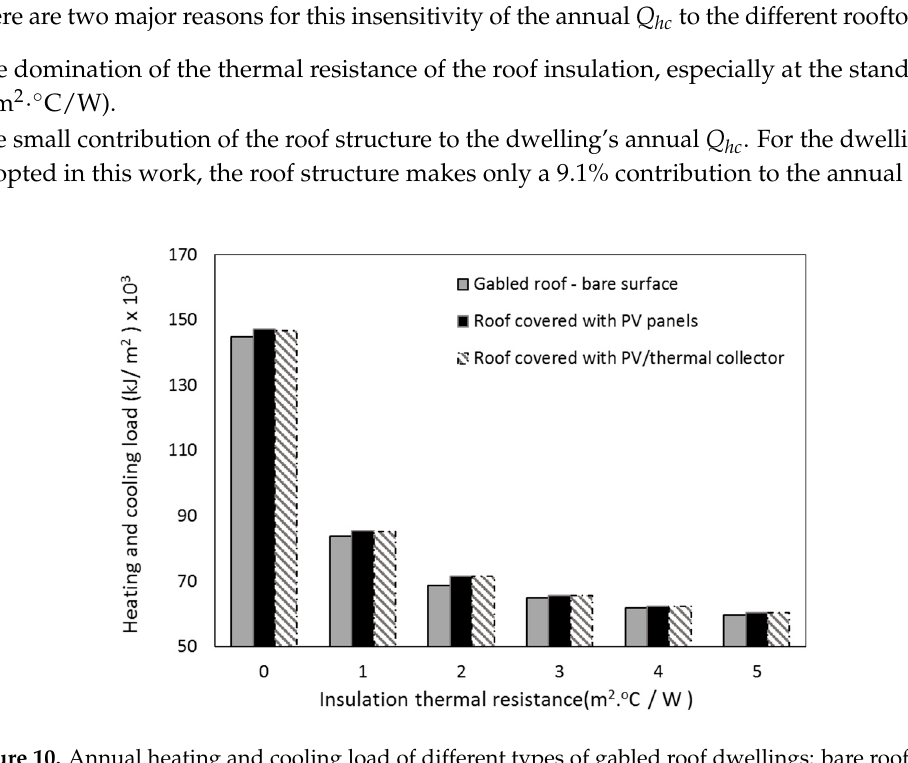
Figure 10. Annual heating and cooling load of different types of gabled roof dwellings: bare roof, roof covered with a PV panel only, and roof covered with the first PV/thermal collector of Table 2.